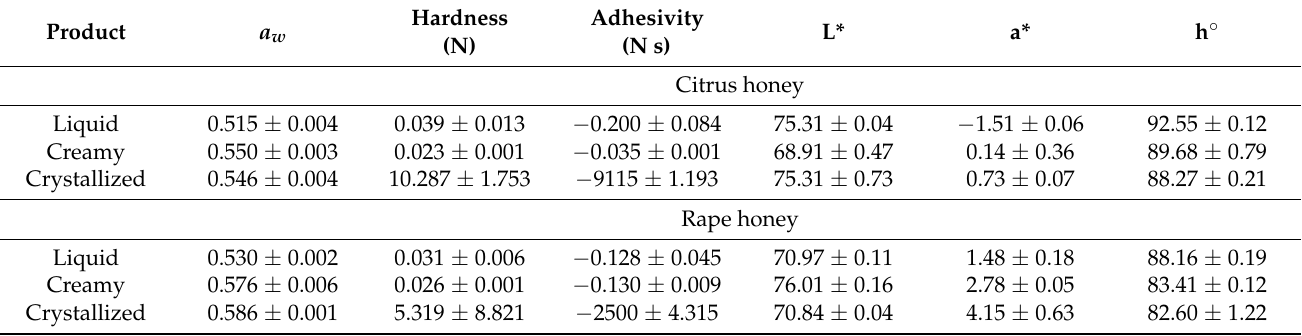
Table 3. Water activity ( a w ) and textural parameters of honey samples ( ± SEM): hardness (N), adhesivity (N s), and color indexes (brightness (L*), red index (a*) and hue angle (h ◦